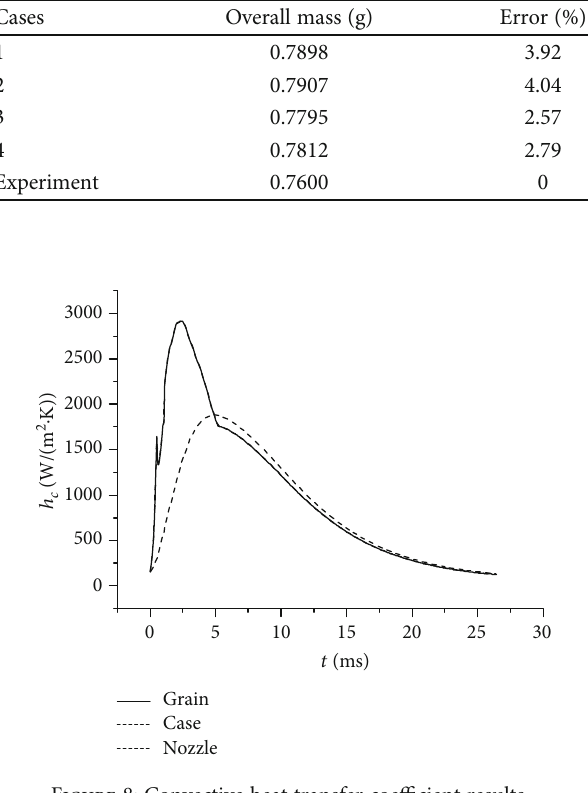
Figure 8: Convective heat transfer coe ffi cient results.